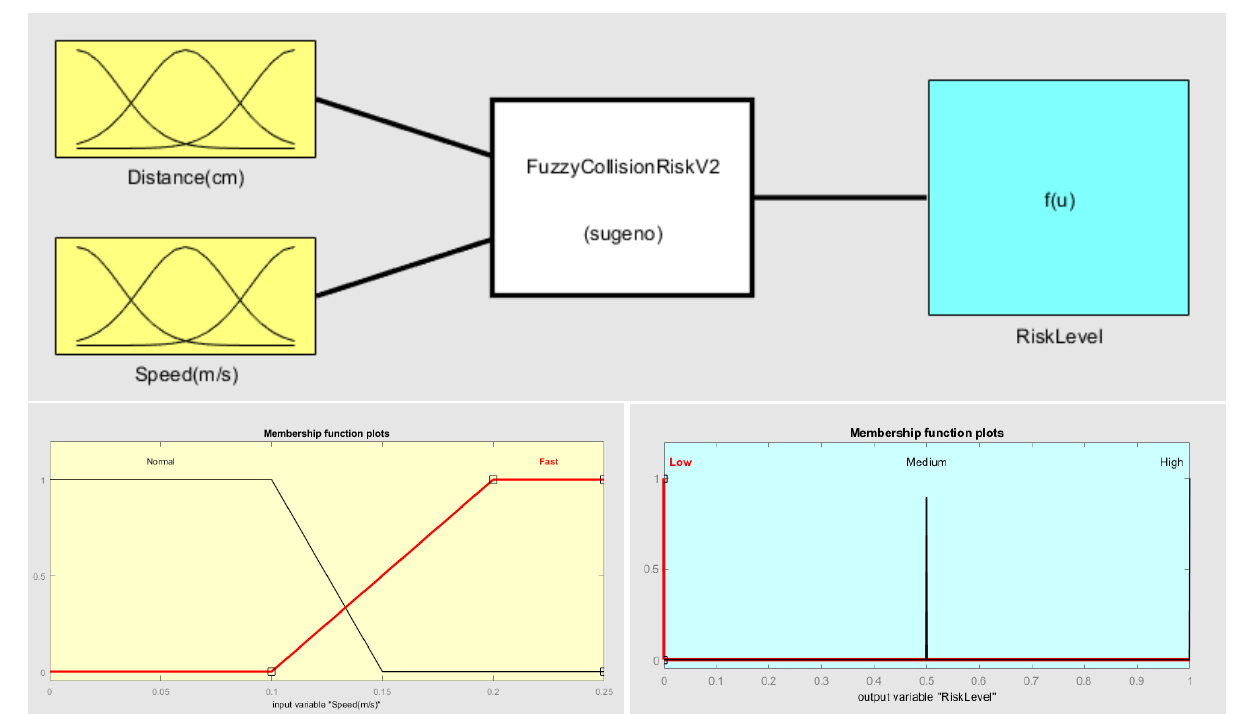
Figure 13. Fuzzy Collision Risk system with two inputs: Distance and Speed.